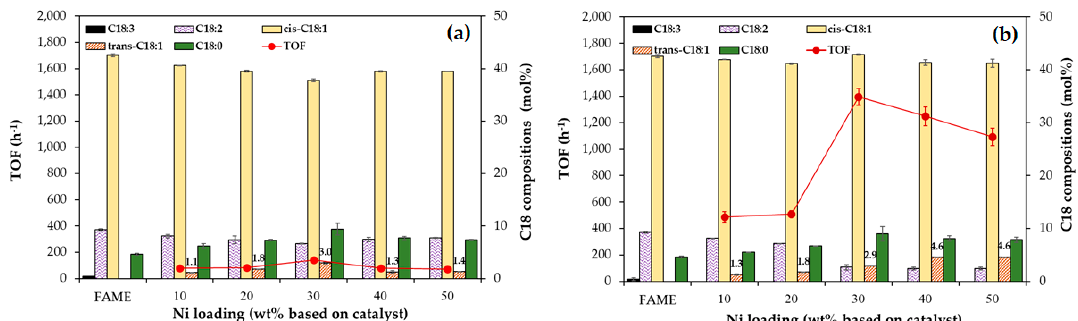
Figure 6. Effect of Ni loading on the degree of turnover frequency (TOF) and C18 compositions in the H- FAME obtained from the partial hydrogenation of palm oil-derived FAME using the ( a ) Ni/SB and ( b ) Ni/SF catalysts under 1 bar H 2 pressure at 140 °C.